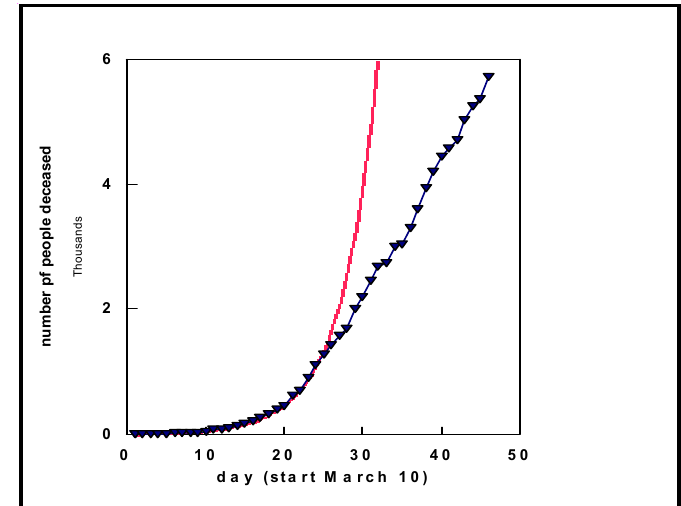
Figure 8. Number of deaths as a function of time for Germany during the period 10 March–24 April 2020. The experimental data (solid triangles) are compared to a fitted curve (red curve) using the assumption that each death leads to the eventual death of another 0.24 persons per day (the mathematical fitted function reads 8*(1.24) N − 1 , where N is the number of days from the start of the series, 10 March 2020). Initially the increase follows a cubic (N 3 ) function; after day 30 the increase reflects quadratic (N 2 /0.38) behaviour.